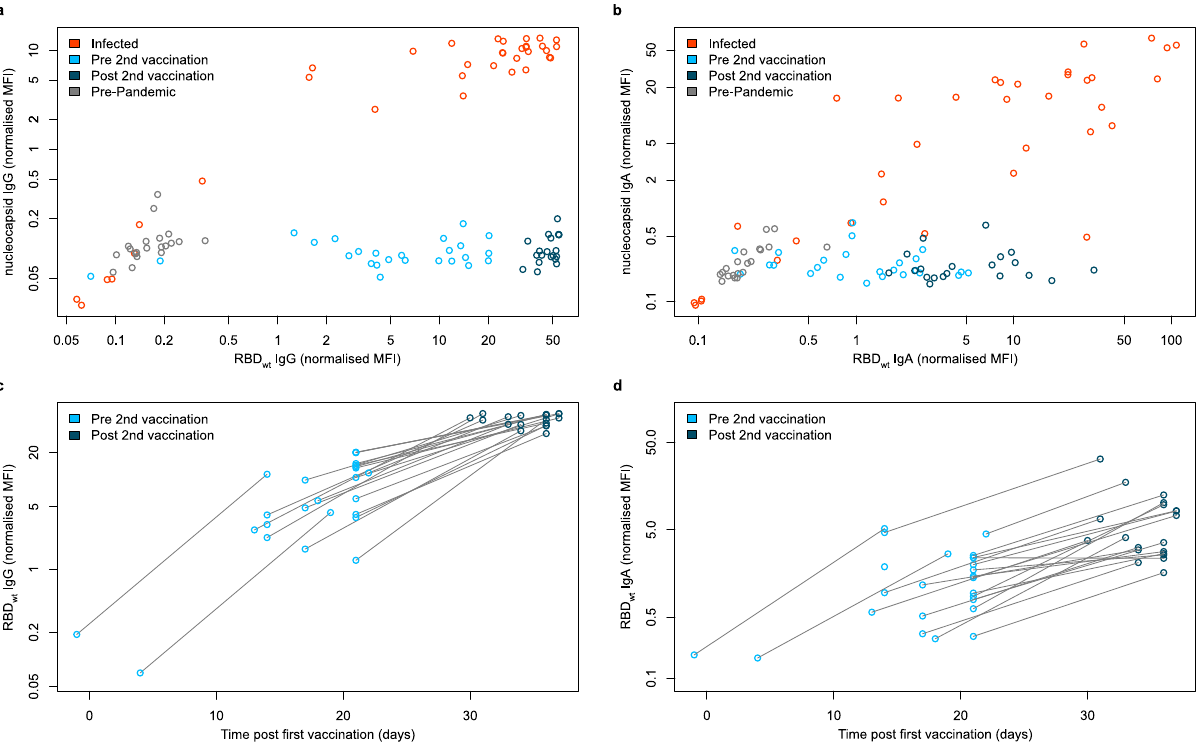
Fig. 1 IgG and IgA response in serum samples of vaccinated, infected, and negative individuals. IgG ( a , c ) and IgA ( b , d ) response in sera from vaccinated (pre second vaccination (light blue, n = 25), post second vaccination (dark blue, n = 20)), infected (red) ( n = 35), and negative (gray) ( n = 20) individuals were measured with MULTICOV-AB. IgG ( a ) and IgA ( b ) response is shown as normalized RBD wild-type (wt) versus normalized nucleocapsid MFI values allowing for visualization of separation between the different groups. Increasing antibody titers in vaccinated individuals for IgG ( c ) and IgA ( d ) is shown with increasing days post vaccination, with samples colored based on whether they are before (light blue) or after (dark blue) the second dose. Lines indicate paired samples from the same donor. Source data are provided as a Source Data fi le.